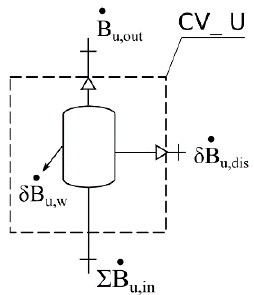
Figure 8. Exergy model for devices.